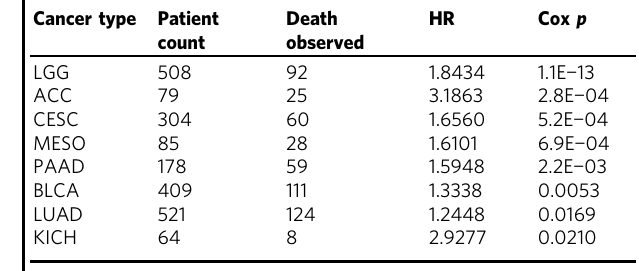
Table 2 TCGA pan cancer analysis independent of stage